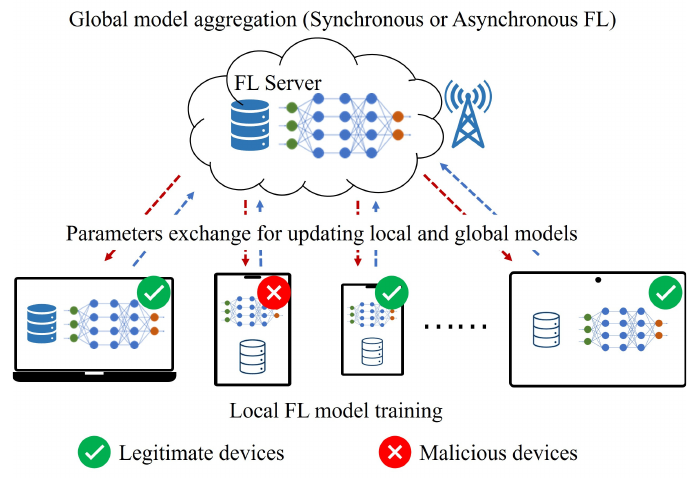
Figure 1. Federated Learning in